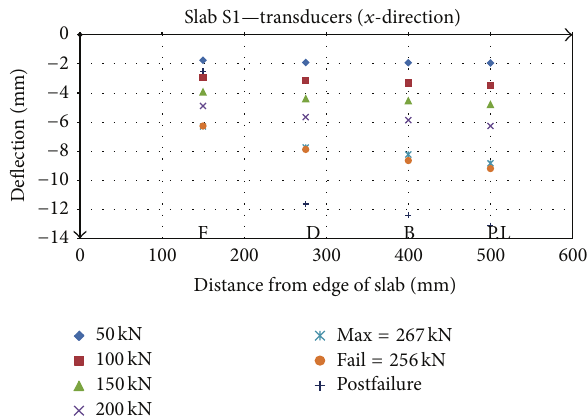
Figure 25: Deflection V’s distance from support ( 𝑥 -direction).